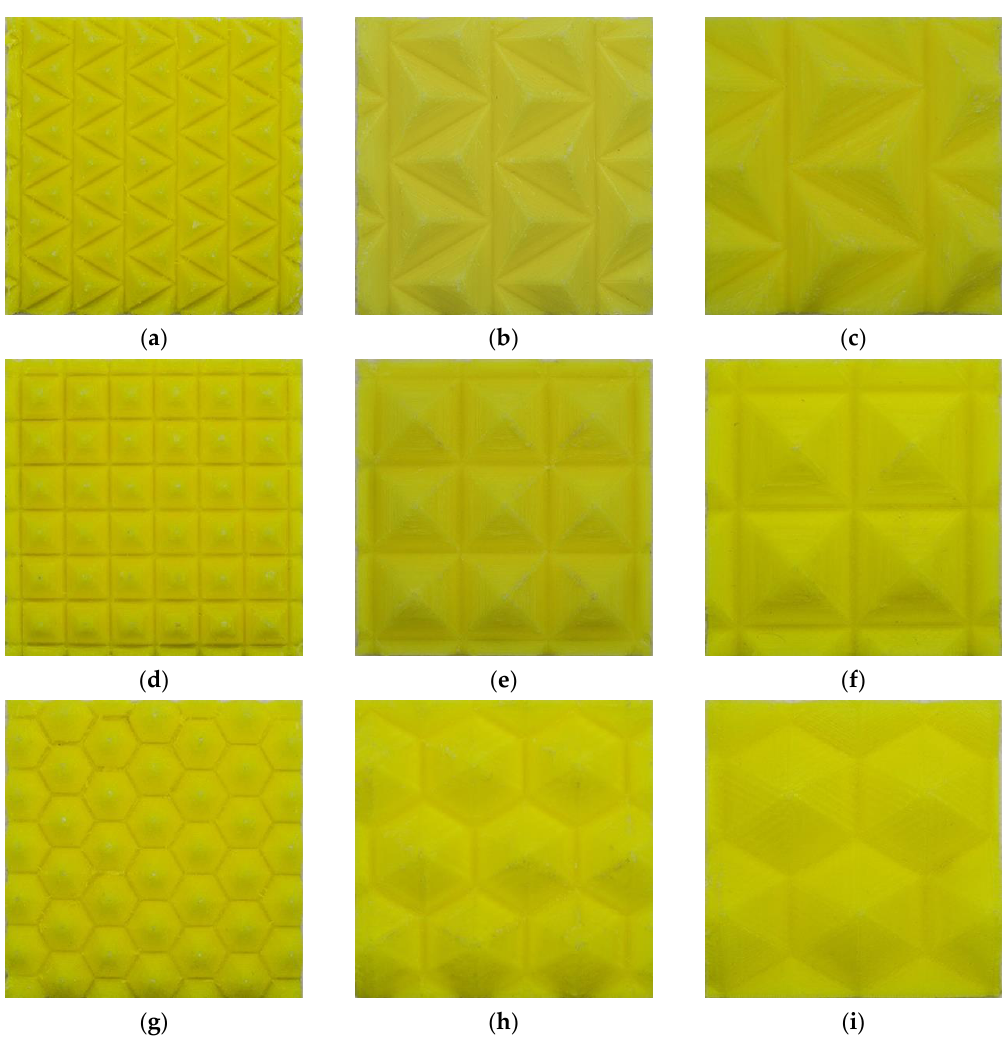
Figure 7. 3D-printed core panels. ( a ) OL-3-1/2; ( b ) OL-3-3/4; ( c ) OL-3-5/6; ( d ) OL-4-1/2; ( e ) OL-4-3/4; ( f ) OL-4-5/6; ( g ) OL-6-1/2; ( h ) OL-6-3/4; ( i ) OL-6-5/6.